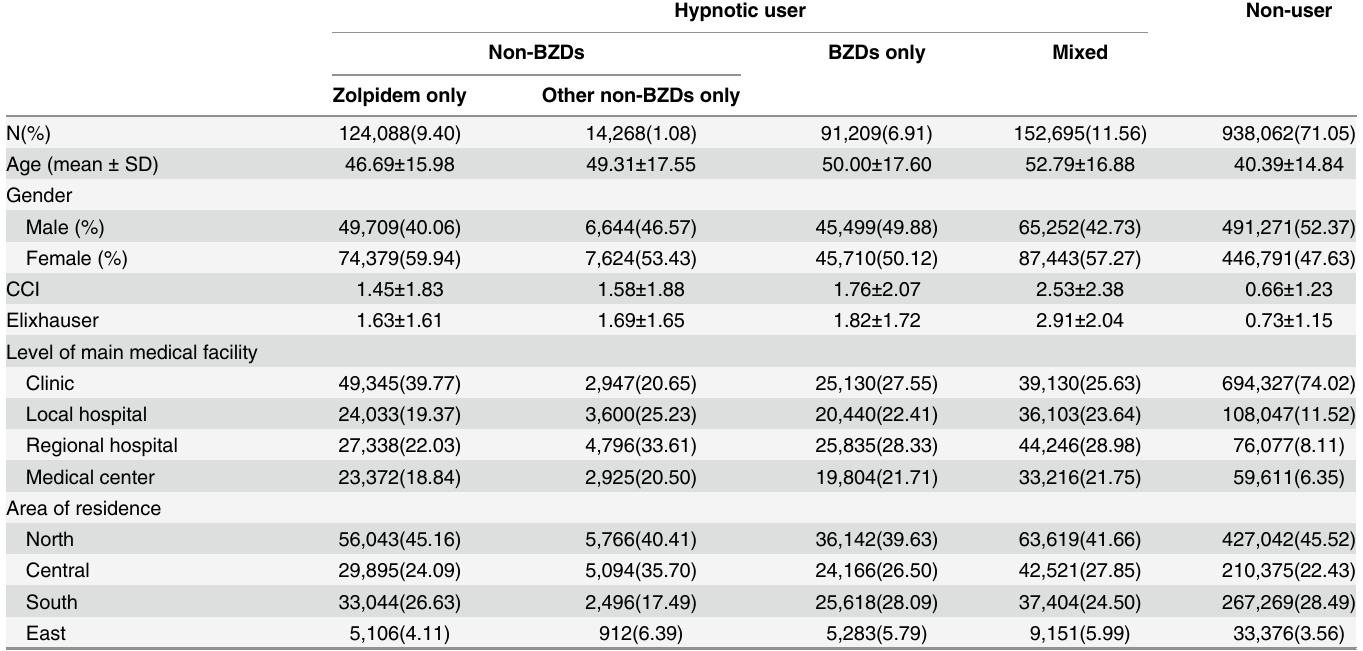
Table 1. Basic characteristics of the different hypnotic groups in the study sample (N = 1,320,322).